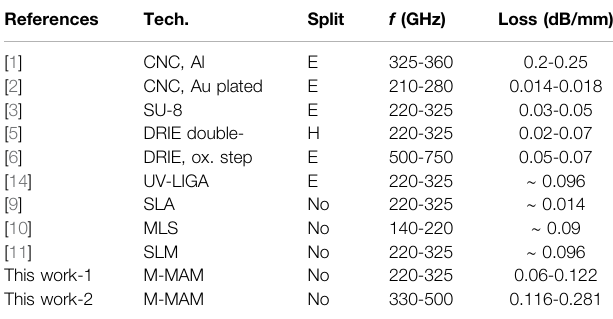
TABLE 1 | State-of-the-art waveguide performance implemented with different technologies